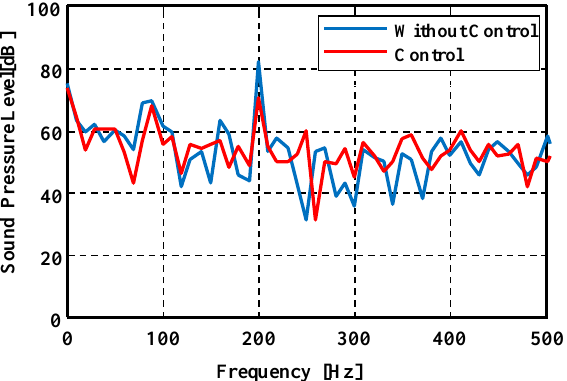
Actuators 2018 , 7 , 49